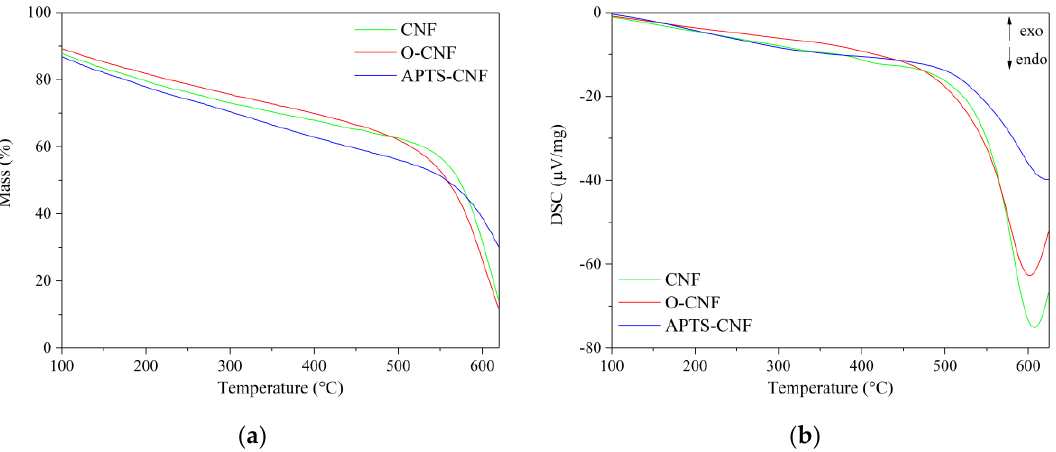
Figure 5. ( a ) Thermogravimetric and ( b ) differential scanning calorimetry (DSC) curves for raw, oxidized, and APTS-modified carbon nanofibers.